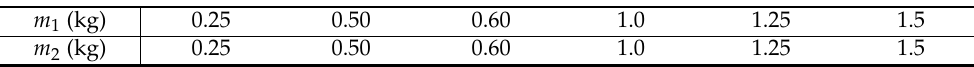
Table A1. Values of m 1 and m 2 used in the experiment (6 × 6 pairs). m 1 (kg) 0.25 0.50 0.60 1.0 1.25 1.5 m 2 (kg) 0.25 0.50 0.60 1.0 1.25 1.5